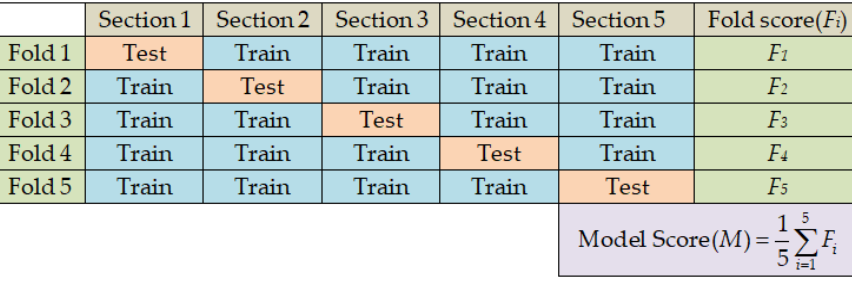
Figure 10. Classification of CXR images using ensemble ‐ CNN ‐ based SVM classifier.